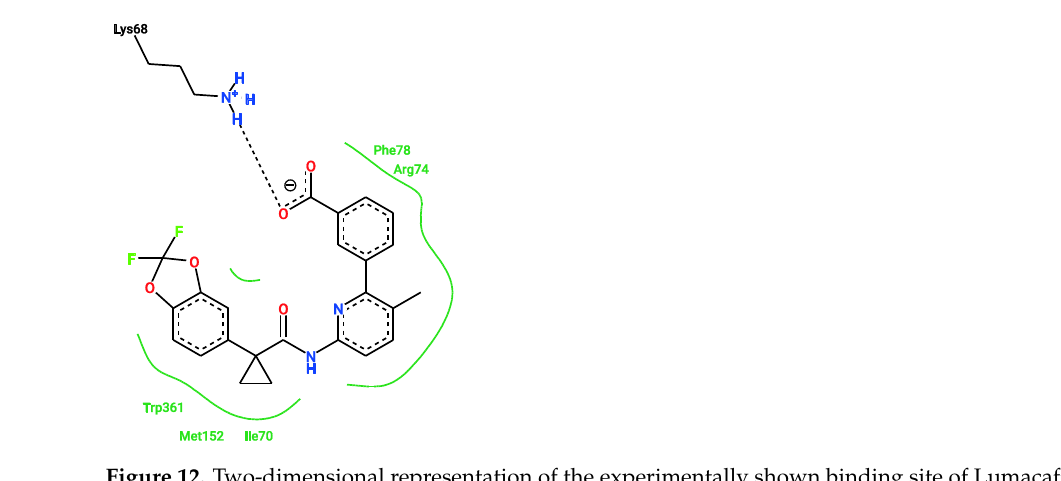
Figure 12. Two-dimensional representation of the experimentally shown binding site of Lumacaftor to CFTR (PDB 7SVD) [63] and predicted interactions between them. Black dashed lines represent hydrogen bonds, green spline sections show hydrophobic interactions and green dashed lines represent π - π stacking or π– cation interactions.